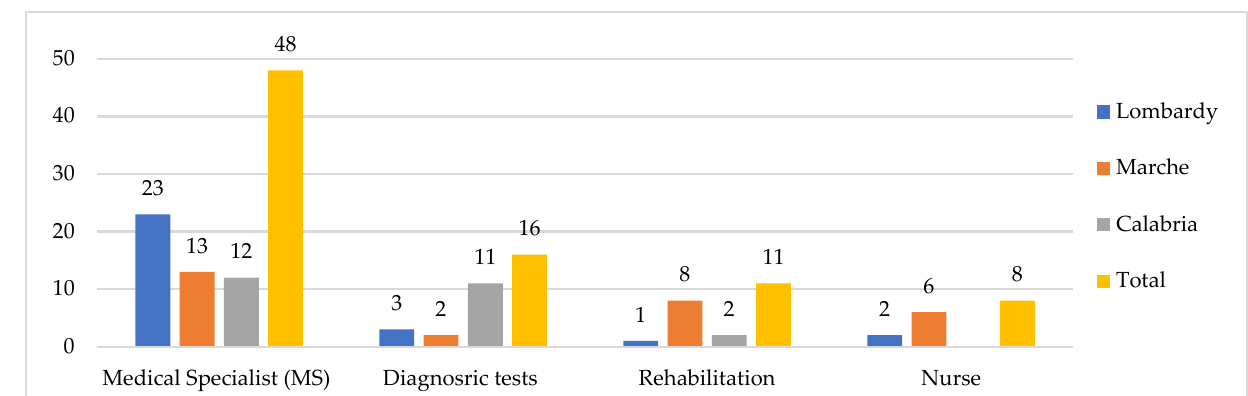
Figure 2. Public health services used by older people, by regions (n, GP excluded). Some respondents reported more than one type of listed public health services. MS was mainly cardiologist, physiatrist, orthopedist and diabetologist. Diagnostic tests were mainly blood/urine tests, ultrasound, electrocardiogram (ECG), and computed axial tomography (TAC). Also, nurses at home for injections, withdrawals and catheter management.